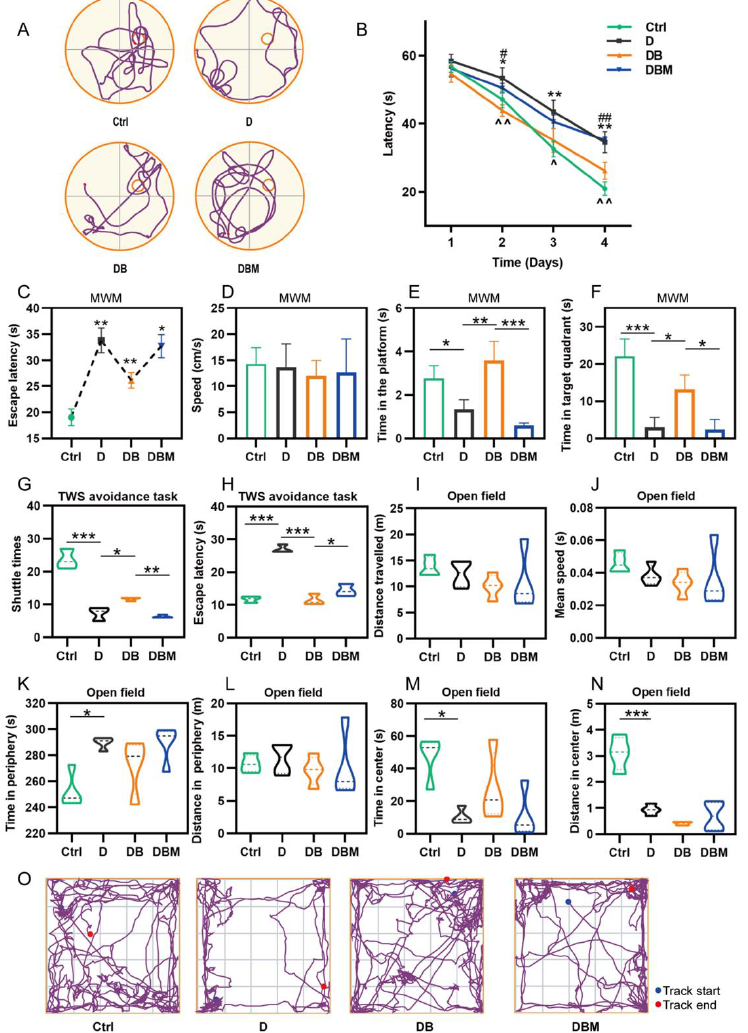
Figure 6. Effects of BBR and D-ribose on APP/PS1 mouse spatial learning and memory and anxiety-like behavior. Compared with the control group, the D group had longer escape latency and shorter target quadrant time, which could be reversed by adding BBR; however, the DBM group showed similar results with the D group after adding Midivi-1 ( A – F ). Compared with the control group, the shuttle times in the D group were significantly reduced and the escape latency was increased. Berberine could significantly reverse the effect of D-ribose, but the DBM group showed fewer shuttle times and longer escape latency after the addition of Midivi-1 ( G , H ). Compared with the control group, the mice of the D group spent a longer time in the periphery and a shorter time and distance in center. The effect of D-ribose is not affected after taking BBR or Midivi-1 ( I – O ). Morris water maze ( A – F ). The representative swimming trace of the mice ( A ), avoid platform la- tency in visible ( B ) and hidden ( C ) tasks, swimming speed ( D ), time in the platform location ( E ) and time in the target quadrant ( F ). Two-way shuttle (TWS) avoidance task ( G – H ). Escape latency ( G ), the time when the mouse first moves to the adjacent chamber; Shuttle times ( H ), including ac- tive avoidance times and passive avoidance times. Open field ( I – O ). The total distances traveled